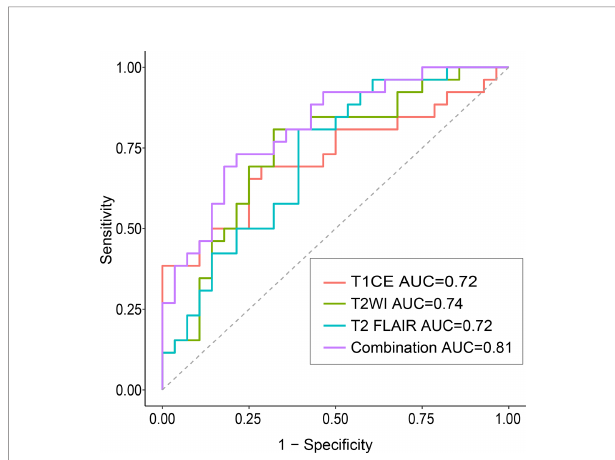
FIGURE 5 | The decision curve analyses of various models The best decision bene fi t was observed with the combined model. T1CE, contrast- enhanced T1-weighted imaging; T2-FLAIR, T2 fl uid-attenuated inversion recovery; T2WI, T2-weighted imaging; combination, combined model extracting features from three sequences.